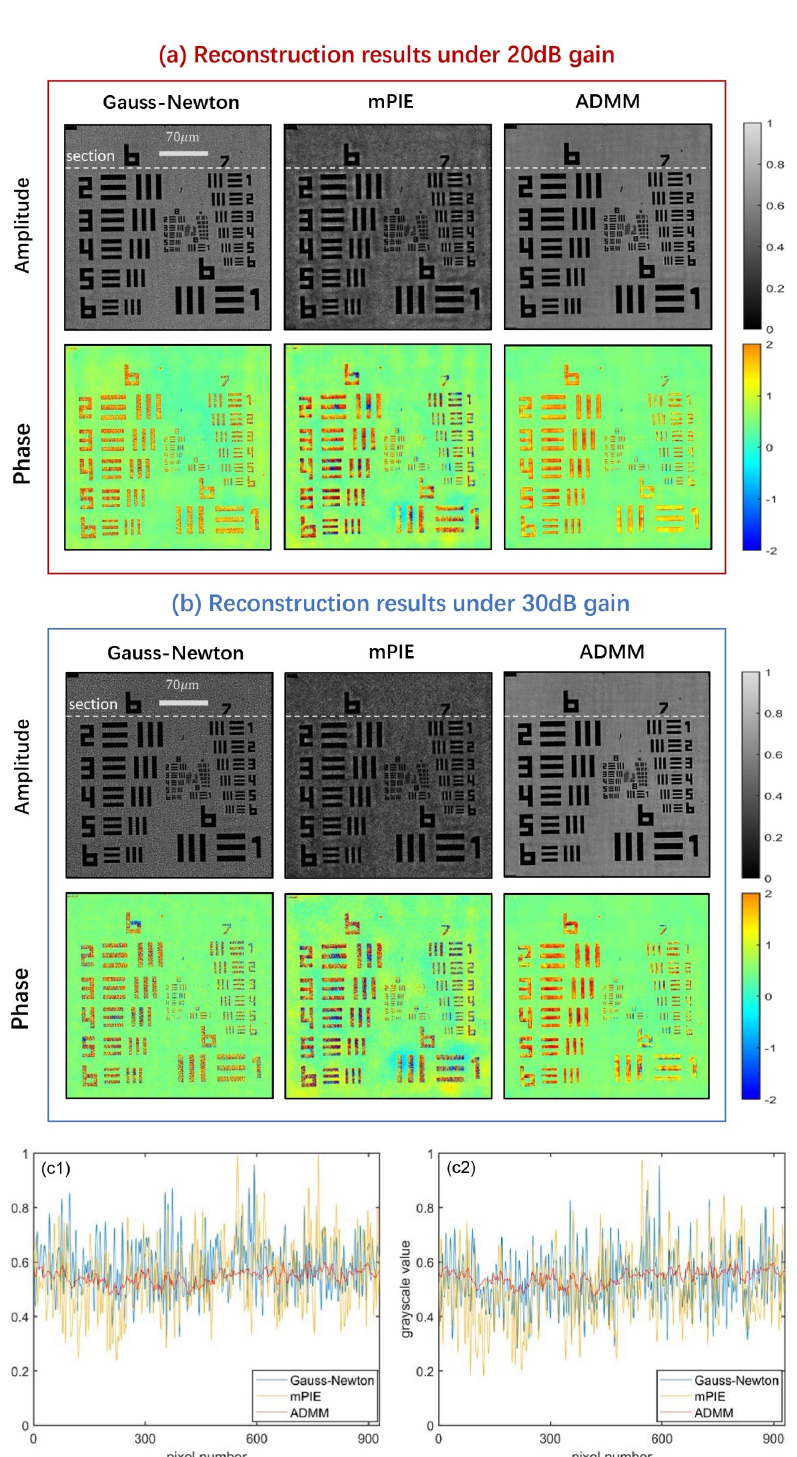
Figure 6. Comparison of experimental reconstruction results for a USAF resolution target under ( a ) 20 dB gain and ( b ) 30 dB gain. ( c1 , c2 ) Plot of the grayscale value of pixels along a certain horizontal section (marked in ( a , b )) for amplitude reconstruction images under 20 dB and 30 dB gain, respectively.